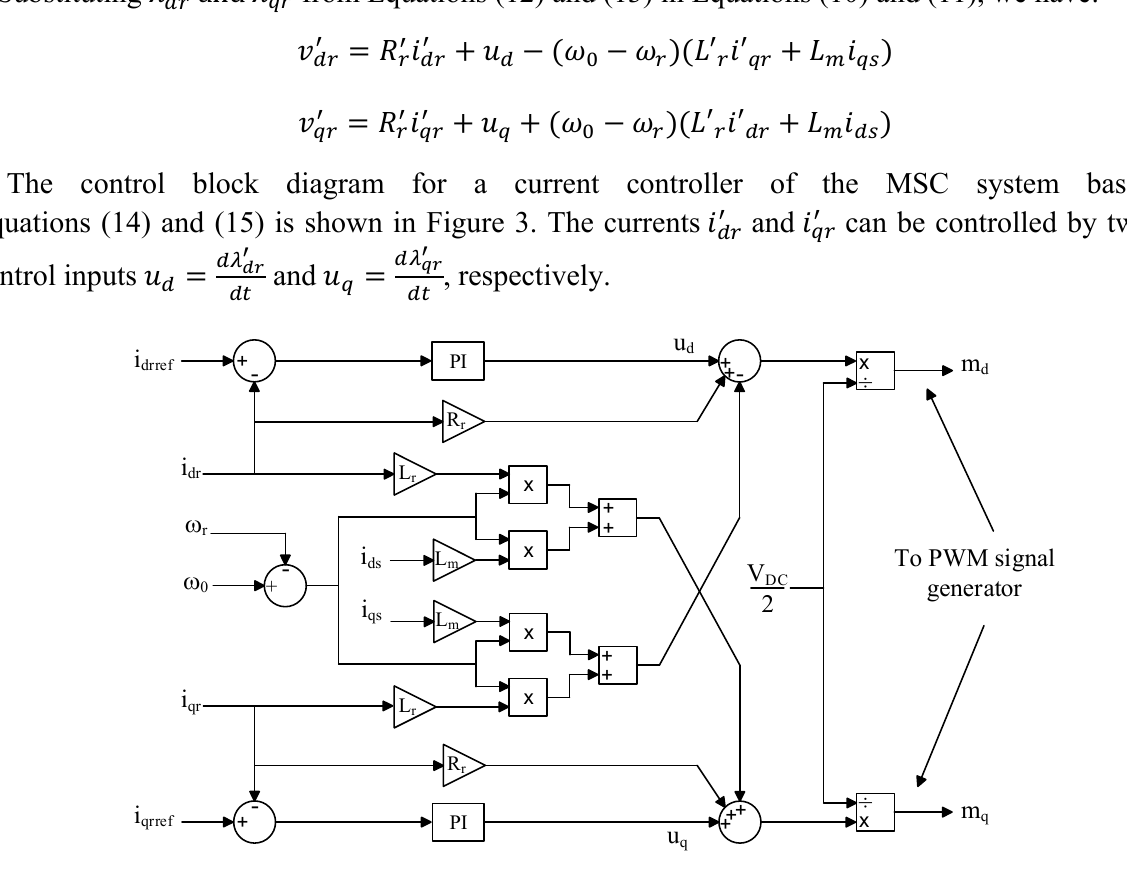
Figure 3. Control block diagram of the current controller of the machine-side